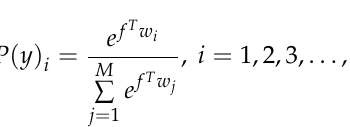
Figure 3. Global average pooling with stride 2.